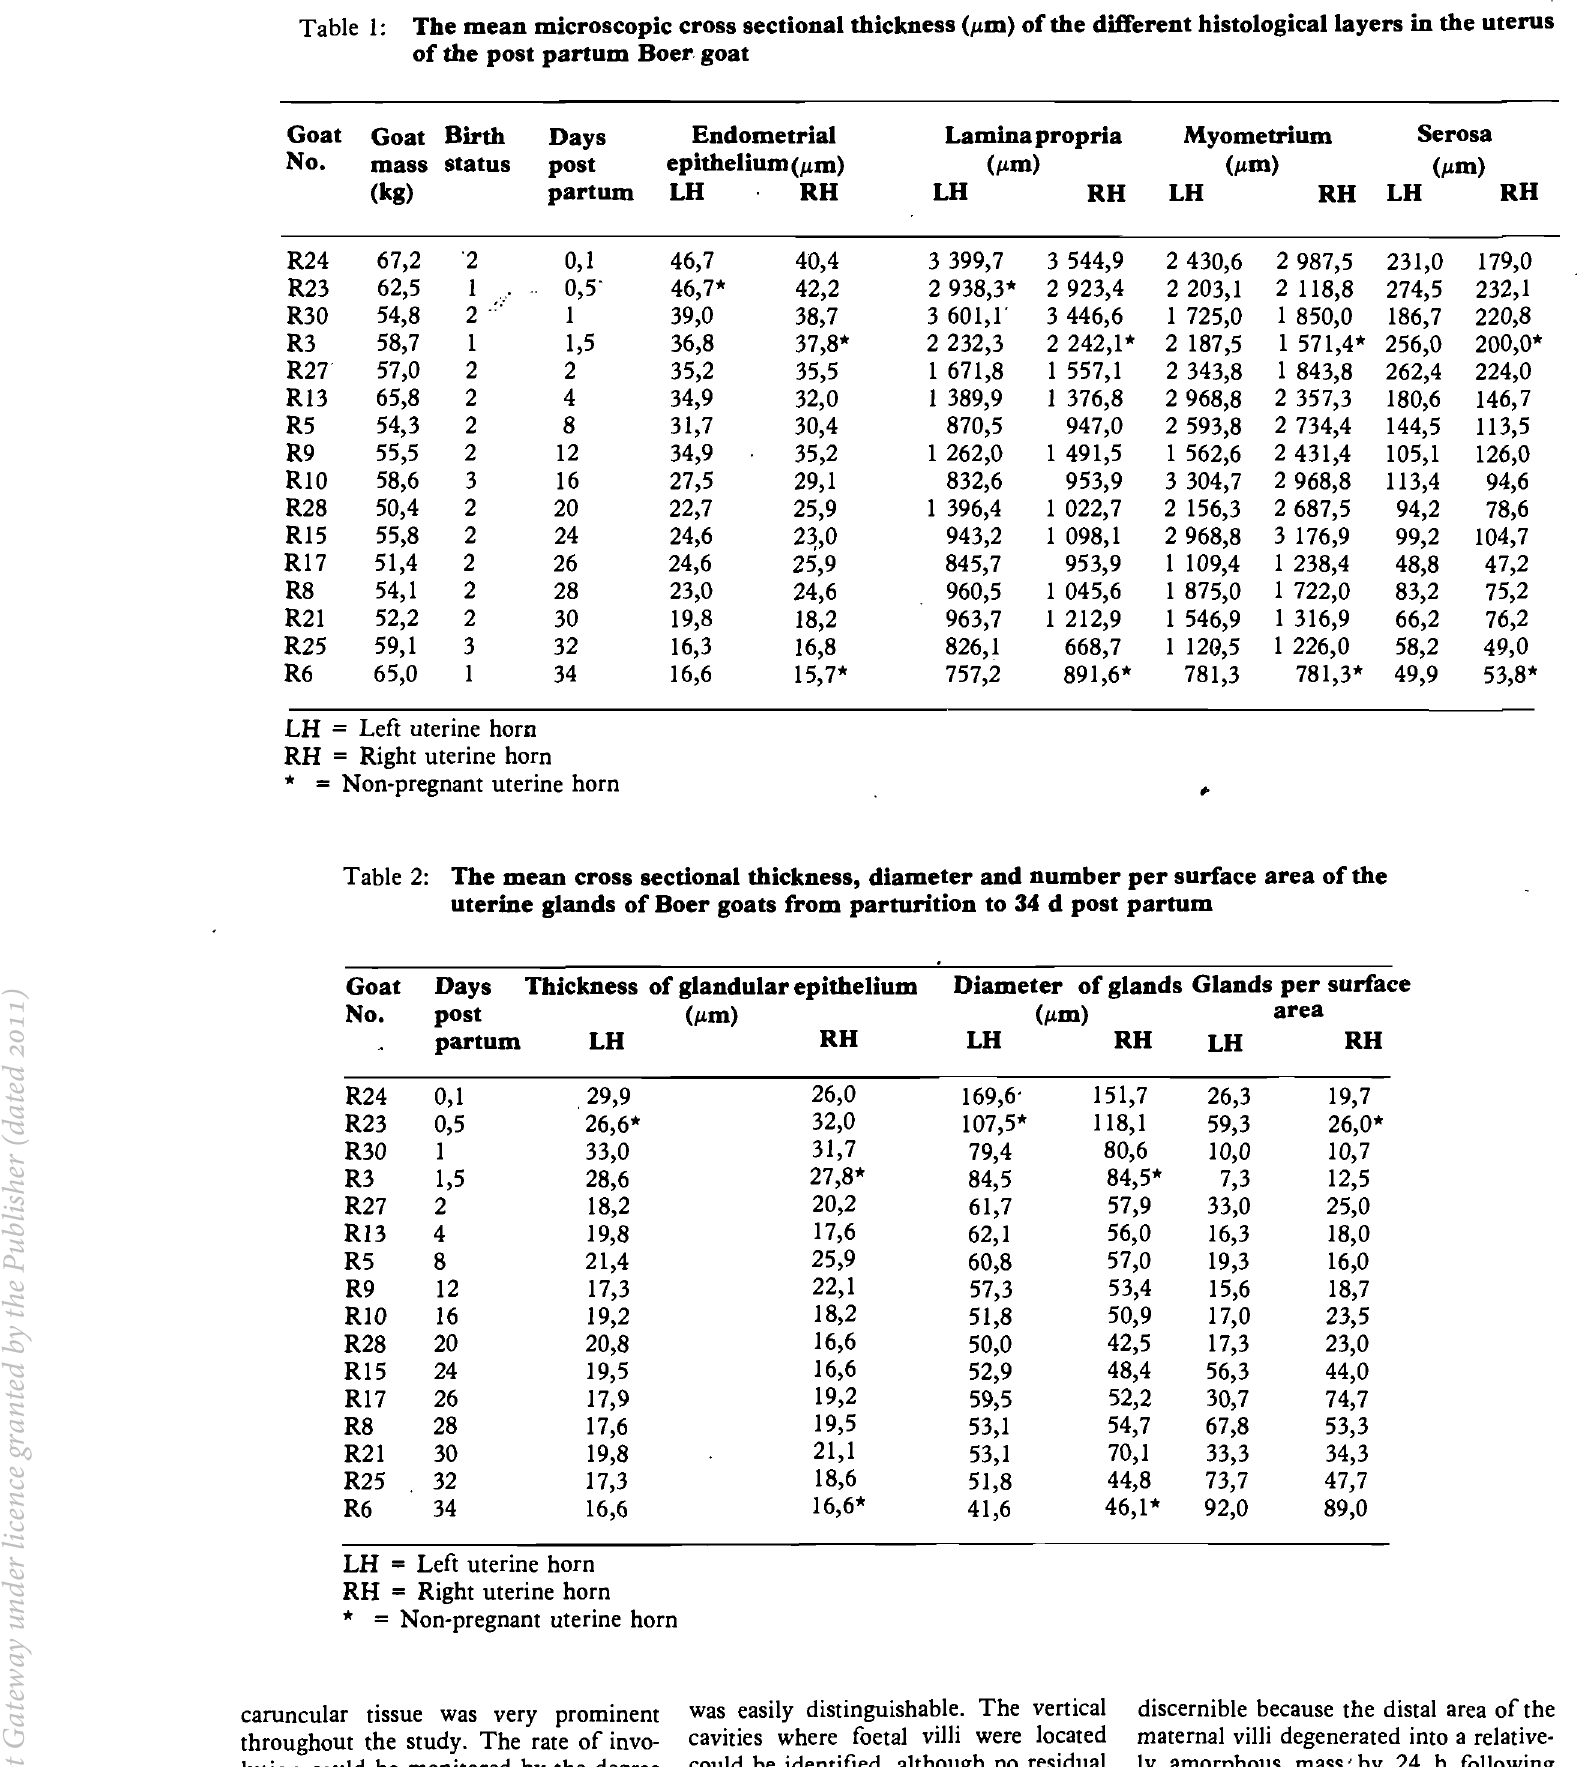
Table 2: The mean cross sectional thickness, diameter and number per surface area of the uterine glands of Boer goats from parturition to 34 d post partum Goat Days Thickness of glandular epithelium Diameter of glands Glands per